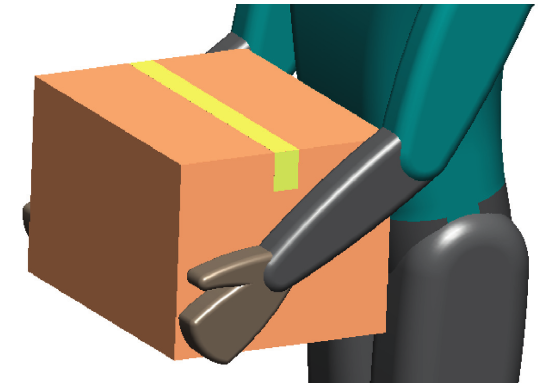
Figure 3: Man grabbing a